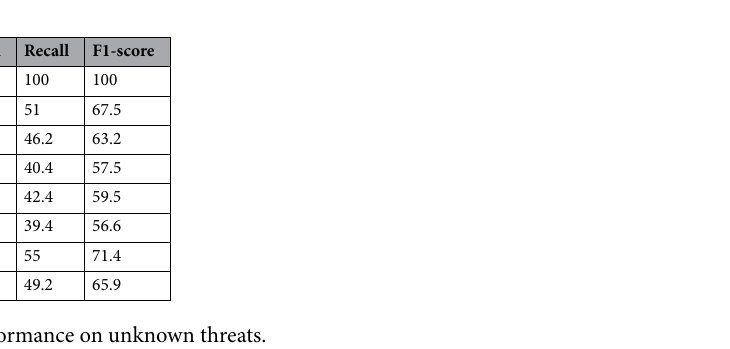
Table 4. ML Classifier performance on unknown